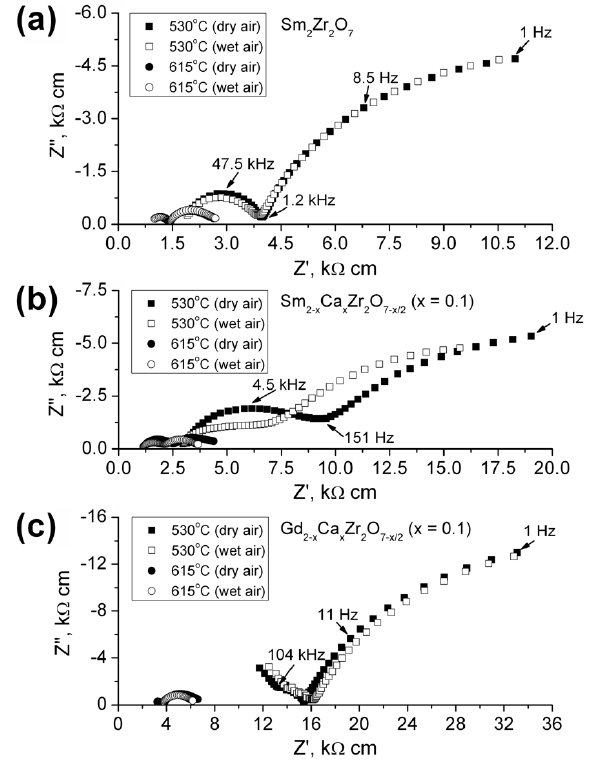
Figure 5. Impedance spectra of ( a ) Sm 2 Zr 2 O 7 , ( b ) Sm 2 − x Ca x Zr 2 O 7 − x/2 (x = 0.1), and ( c ) Gd 2 − x Ca x Zr 2 O 7 − x/2 (x = 0.1) at 530 and 615 °C in dry and wet air.